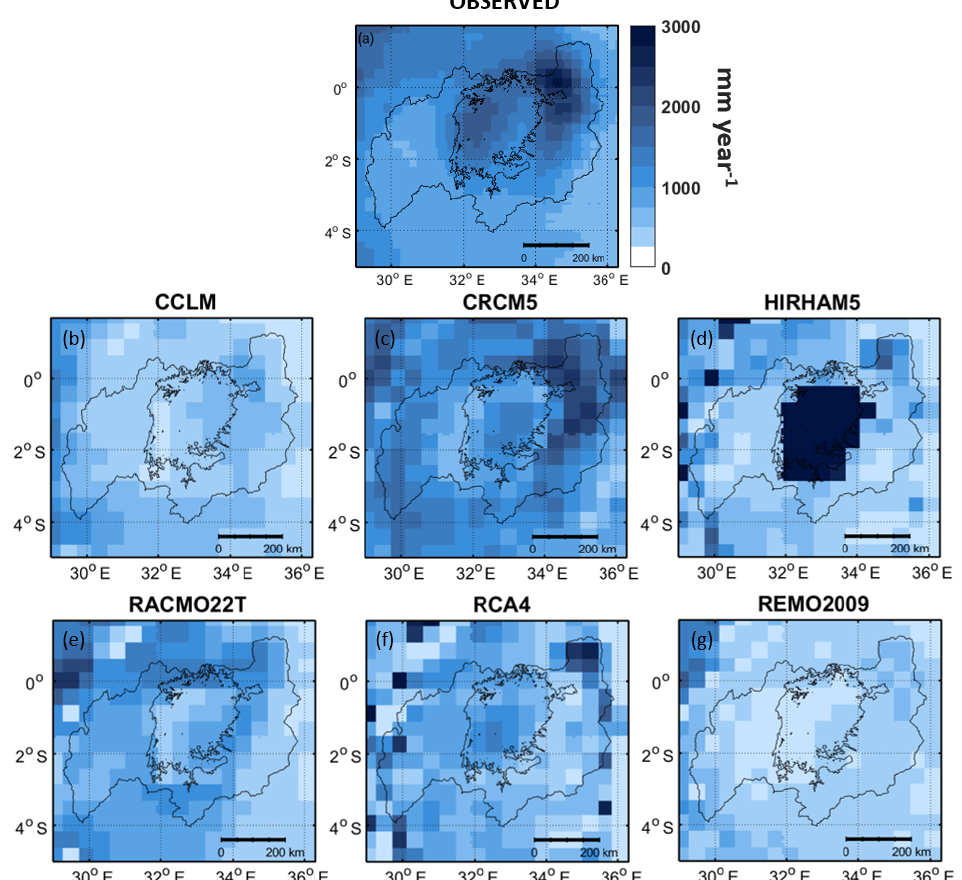
Figure 2. Annual accumulated precipitation during the period 1993–2008 as derived from PERSIANN-CDR (a) the CORDEX evaluation simulations (b–g)